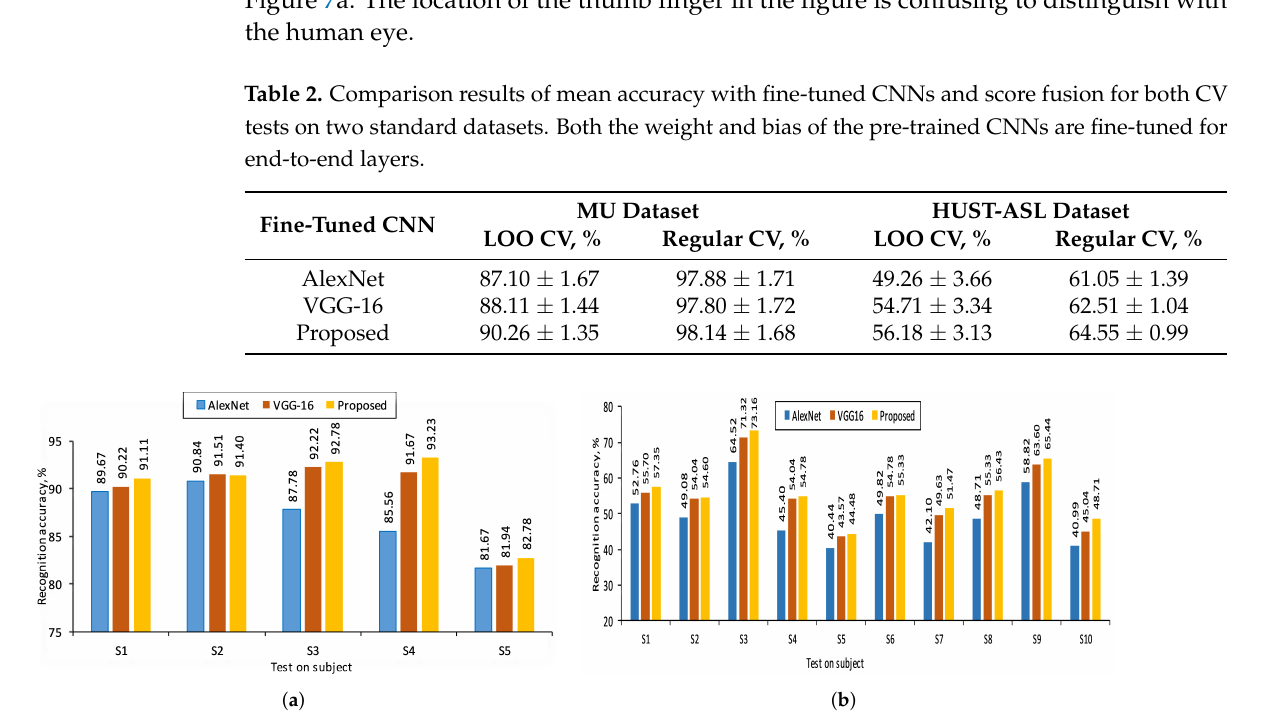
Figure 4. The subject-wise comparison of recognition accuracy in the LOO CV test on both datasets used: ( a ) MU dataset; ( b ) HUST ASL dataset.